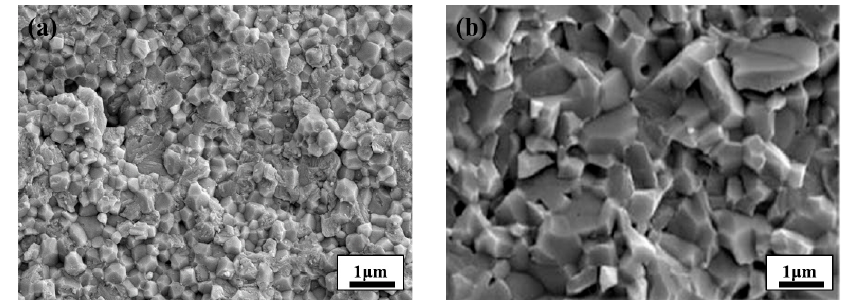
Figure 2. Fracture Morphology Images: ( a ) ZrO 2 Ceramics; ( b ) Al 2 O 3 Ceramics.